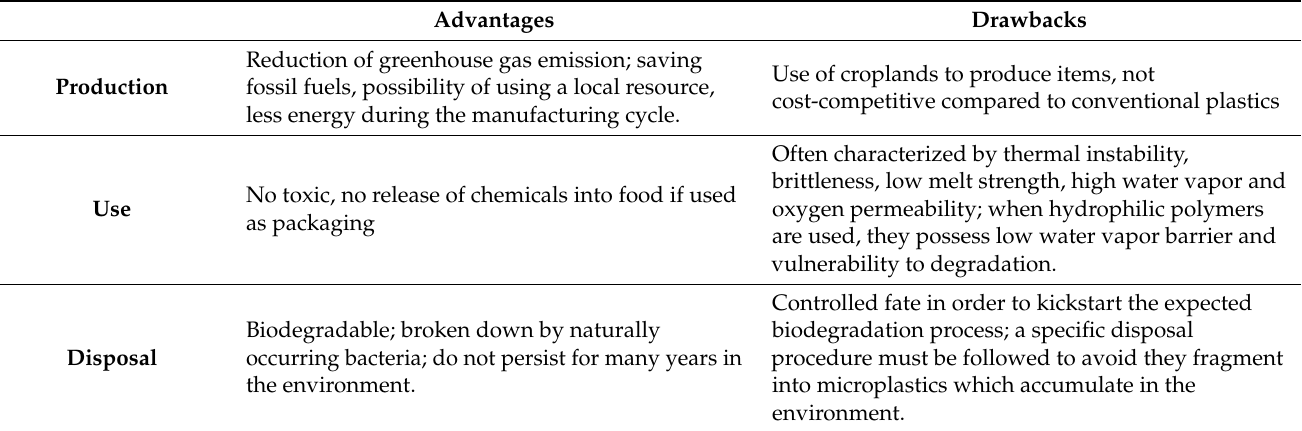
Table 2. Main advantages and drawbacks related to the production and the use of bioplastic